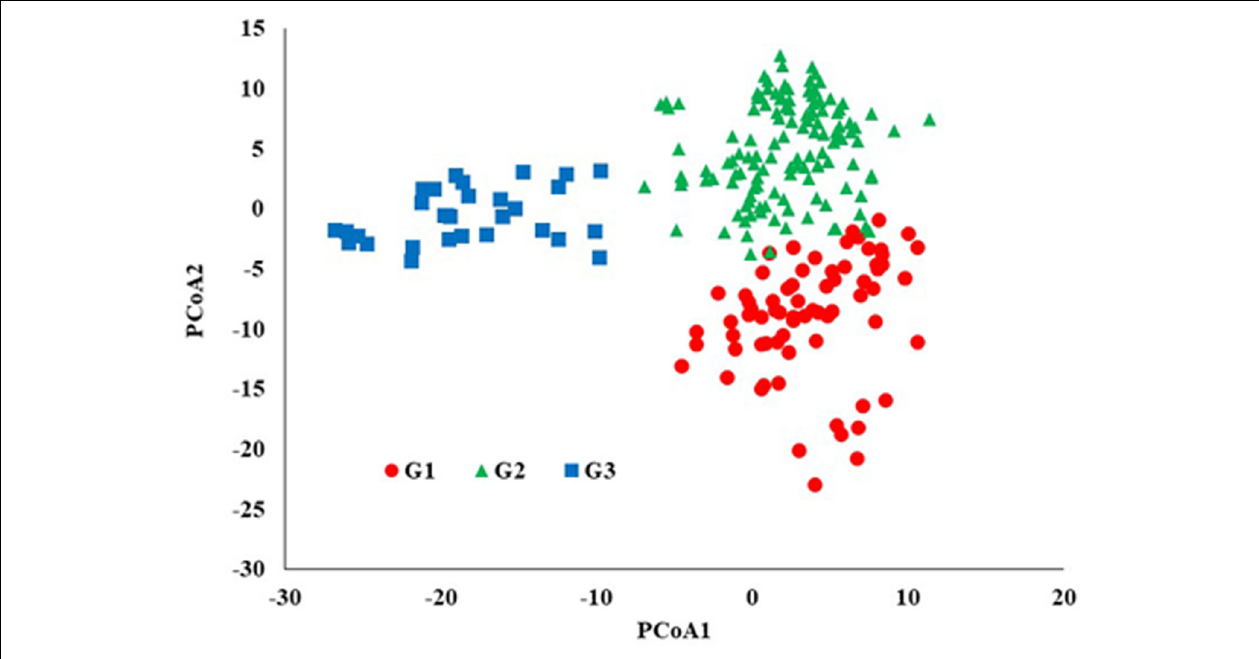
FIGURE 4 | Principal coordinates analysis (PCoA) based on genetic distance (SNPs). TABLE 3 | Analysis of molecular variance using 25, 566 SNPs of the genetic differentiation among and within three subpopulations of 230 F 3 : 6 lines in the Nebraska breeding program.